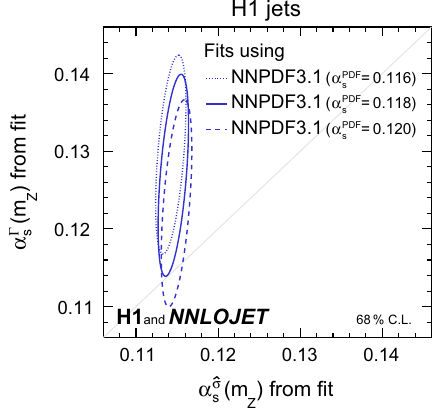
Fig. 3 Results from fits to H1 jets with two free fit parameters for α ( m ) ,wheretheappearancesof α s Z and in the partonic cross sections α σ s ( m Z ) are identified separately. The ellipses display a confidence level of 68% including the experimental, hadronisation and PDF uncertainties, and thus the lines are calculated for (cid:10)χ 2 = 2 . 3. The dotted, full and dashed lines indicate the con- tour for (cid:10)χ 2 = 2 . 3 using three versions of the NNPDF3.1 set which were obtained using values for α PDF s ( m Z ) of 0.116, 0.118 and 0.120, respectively